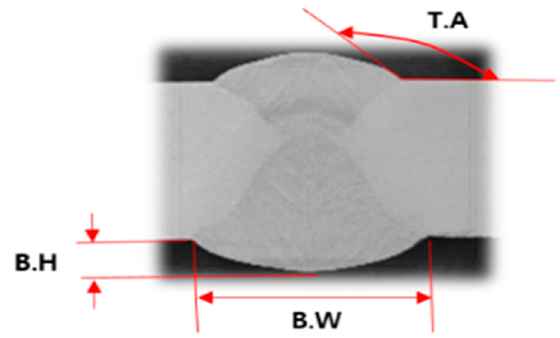
Figure 6. Definition of measuring items.